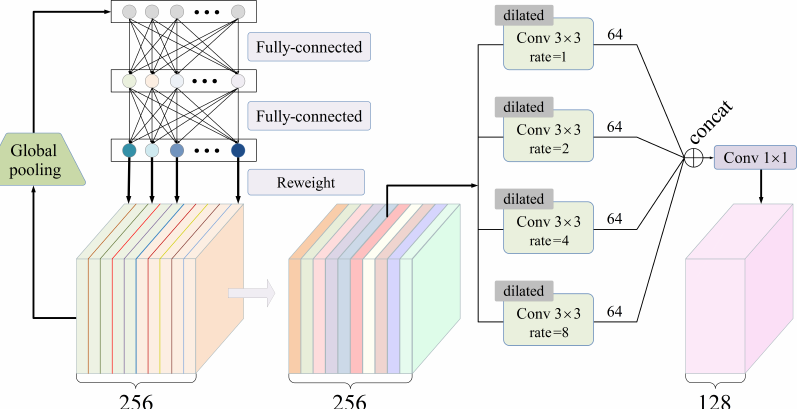
Figure 3. The schematic illustration of the SE-based fusing module, where the number of channels C is set to